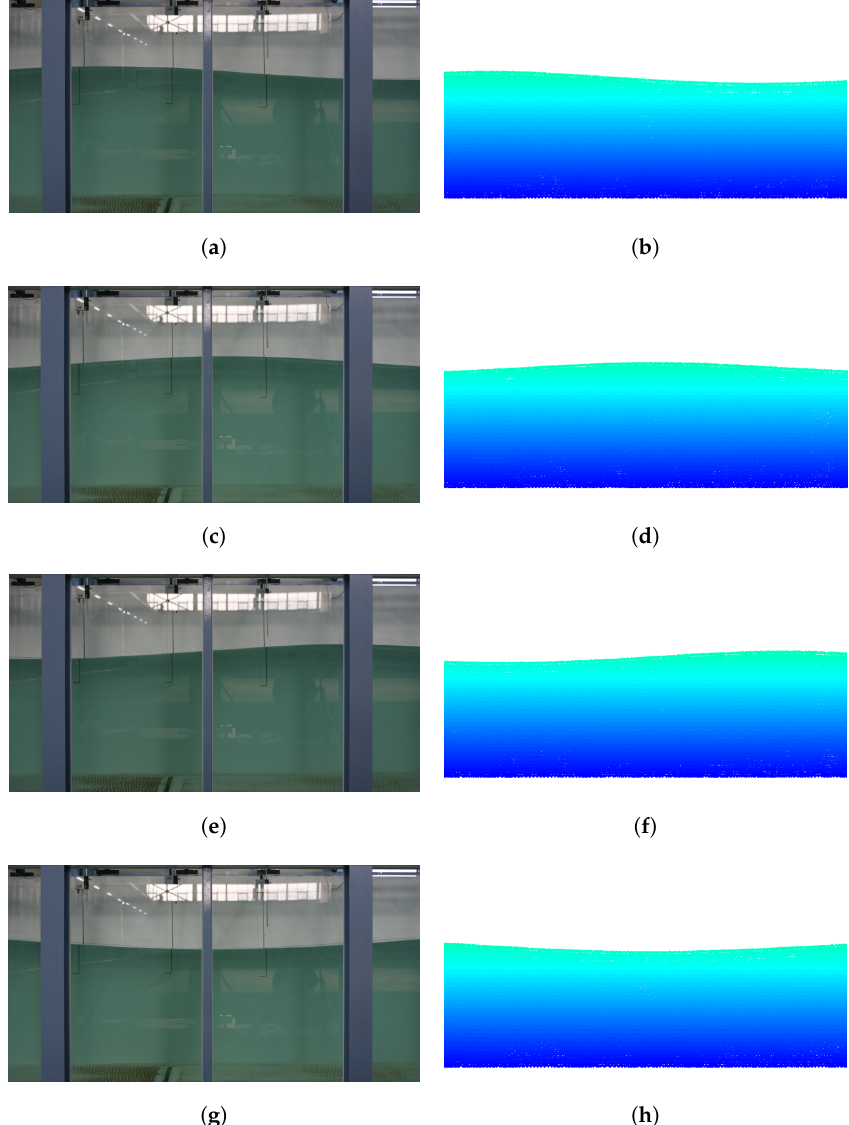
Figure 12. Comparison of the linear waves in experiments (left) and numerical simulations (right) of Case IV-2.